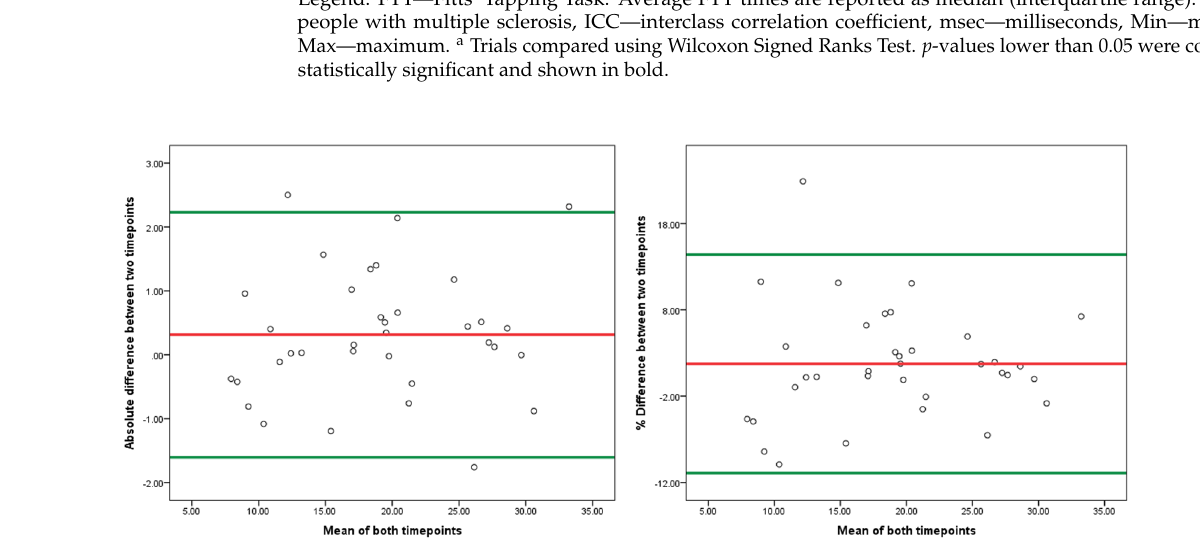
Figure 2. Bland–Altman plots depicting the reproducibility of the FTT including all measures (6 Fitts’ difficulties) and the average FTT score (average of the 12 trials together). Legend: FTT − Fitts’ Tapping Task. Left − absolute difference in Fitts’ Tapping Tasks within the people with multiple sclerosis over 1 ‐ week follow ‐ up, Right − percent difference in Fitts’ Tapping Tasks within the people with multiple sclerosis over 1 ‐ week of follow ‐ up. Each dot represents the difference between the two timepoints over 1 ‐ week. The green lines represent the lower and upper 95% confidence intervals and the red line represents the mean value.